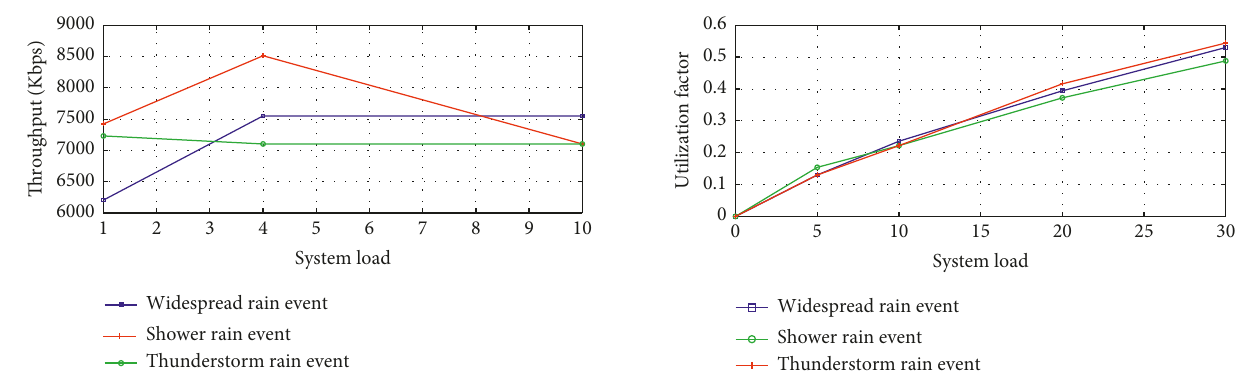
Figure 14: Utilization (ten-period prediction).